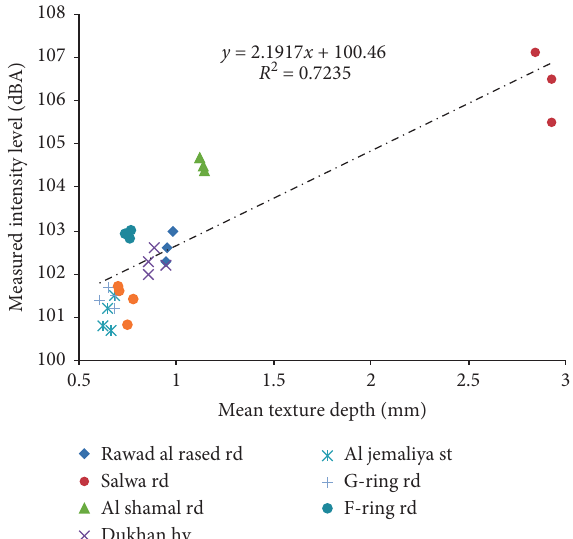
Figure 8: Correlation between mean texture depth (MTD) and overall OBSI level for DGA pavement